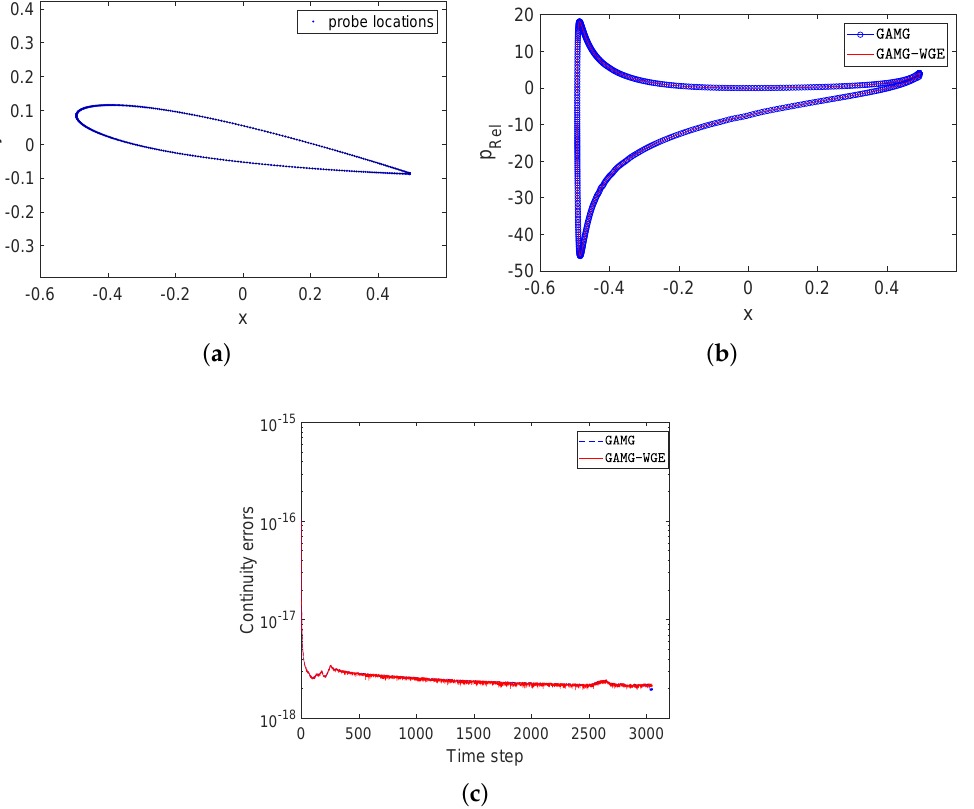
Figure 12. ( a ) The probe locations on the surface of the airfoil, ( b ) the corresponding p Rel field at 0.1 s, and ( c ) the continuity errors using different methods in 2D NACA0012.